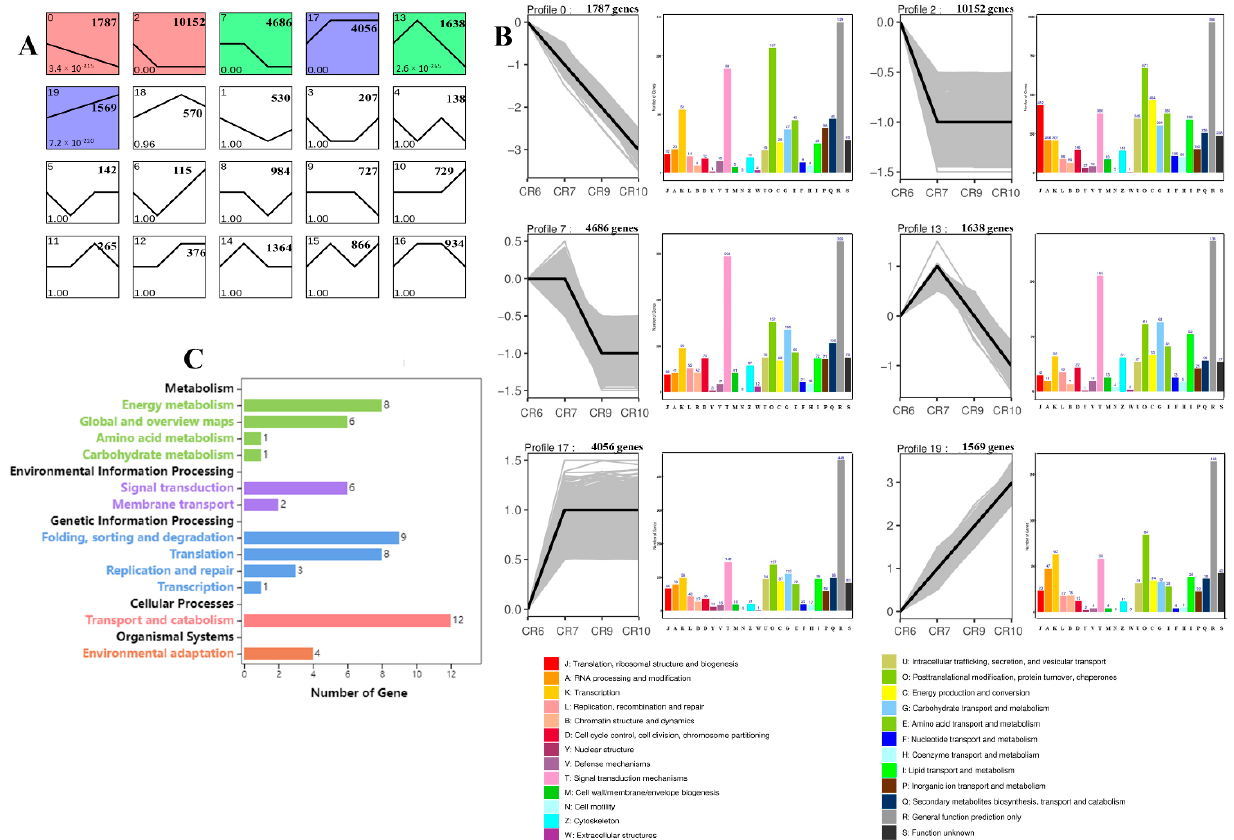
Figure 5. Clusters of total genes and EuKaryotic Orthologous Group (KOG) annotations of profiles. ( A ) All genes were clustered based on their FPKM data with an FDR ≤ 0.05. Profile numbers, p - values, and gene numbers are located in the upper left corner, lower left corner, and upper right corner, respectively. ( B ) Six clusters were obtained by short time-series expression miner (STEM) software using the gene expression profiles. The y -axis of each cluster indicates the log 2 FC value. A p value ≤ 0.05 and a minimum fold change of two were used for KOG analysis. The y − axis of each KOG analysis shows the number of genes. ( C ) Kyoto Encyclopedia of Genes and Genomes (KEGG) pathway annotations of profile 13. The y − axis of each cluster is the KEGG pathway name.